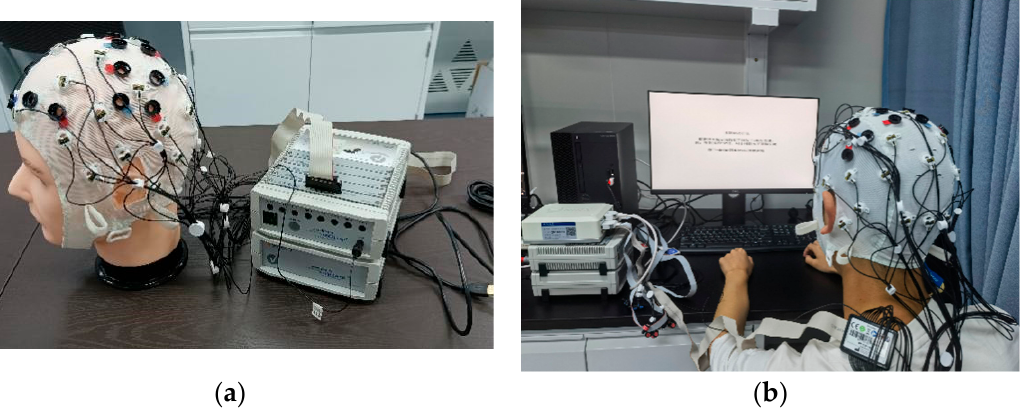
Figure 3. ( a ) The EEG system used in our study; ( b ) the recording scene: a participant is following the instructions showing on the screen when the EEG signals are recorded.